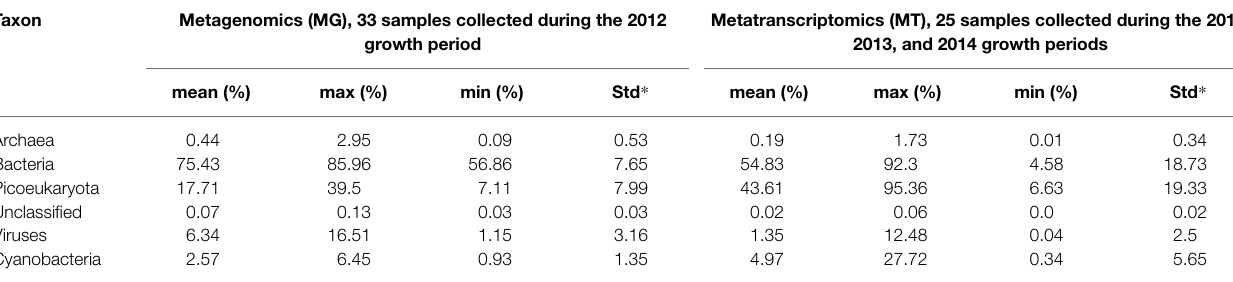
TABLE 1 | Proportion of transporter proteins in selected taxon of the metagenomic and metatranscriptomic datasets. Taxon